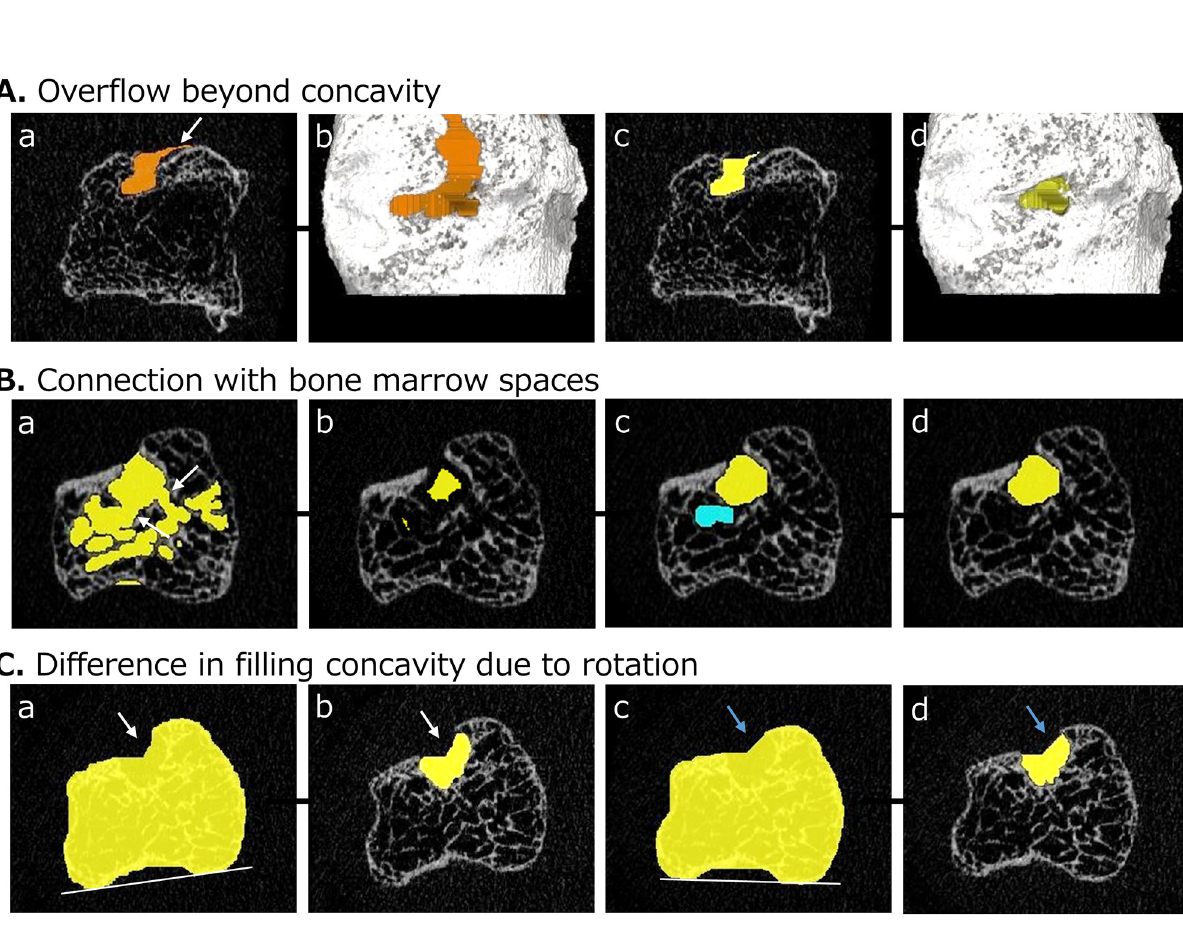
Fig 3. Additional procedures required for some erosions in our algorithm. A. This step may be necessary if the erosion VOI overflows beyond the concavity. a, b) These images represent overflow of the VOI (white arrow) on 2D (a) and 3D (b) images. c, d) The appropriate VOI is created by adding shrinking operations at the step in Fig 1E. B. These steps may be necessary if the erosion VOI connects with bone marrow spaces. a) The primary VOI is connected with the bone marrow spaces. b) The shrinking operation is executed iteratively until the continuity is completely interrupted. c) The dilation operation is executed the same number of times until a return to the original shape is achieved. d) Only the VOI of the erosion is extracted. C. Adjustment of rotation in the axial view may be necessary if the rotation is markedly different in longitudinal analysis. a, c) These images corresponding to the image in Fig 1D are created from the same image. A different rotation causes a slight difference in filling concavities. b, d) The two VOIs of erosions are slightly different due to differences in rotation.